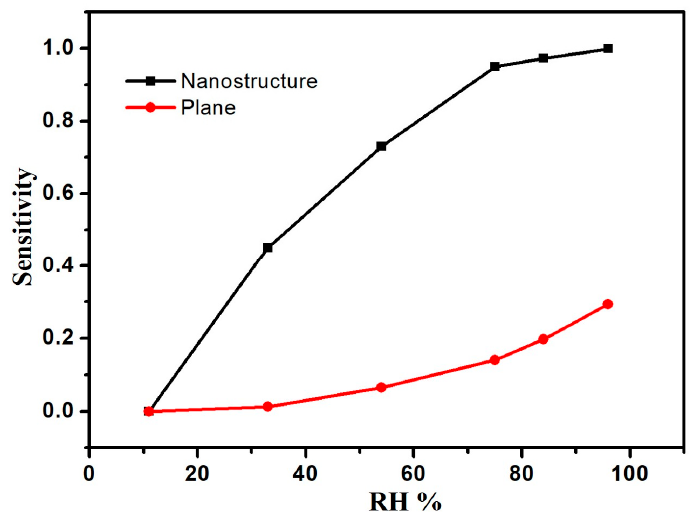
Figure 5. The relation between sensitivity and relative humidity with nanostructure and plane substrate.